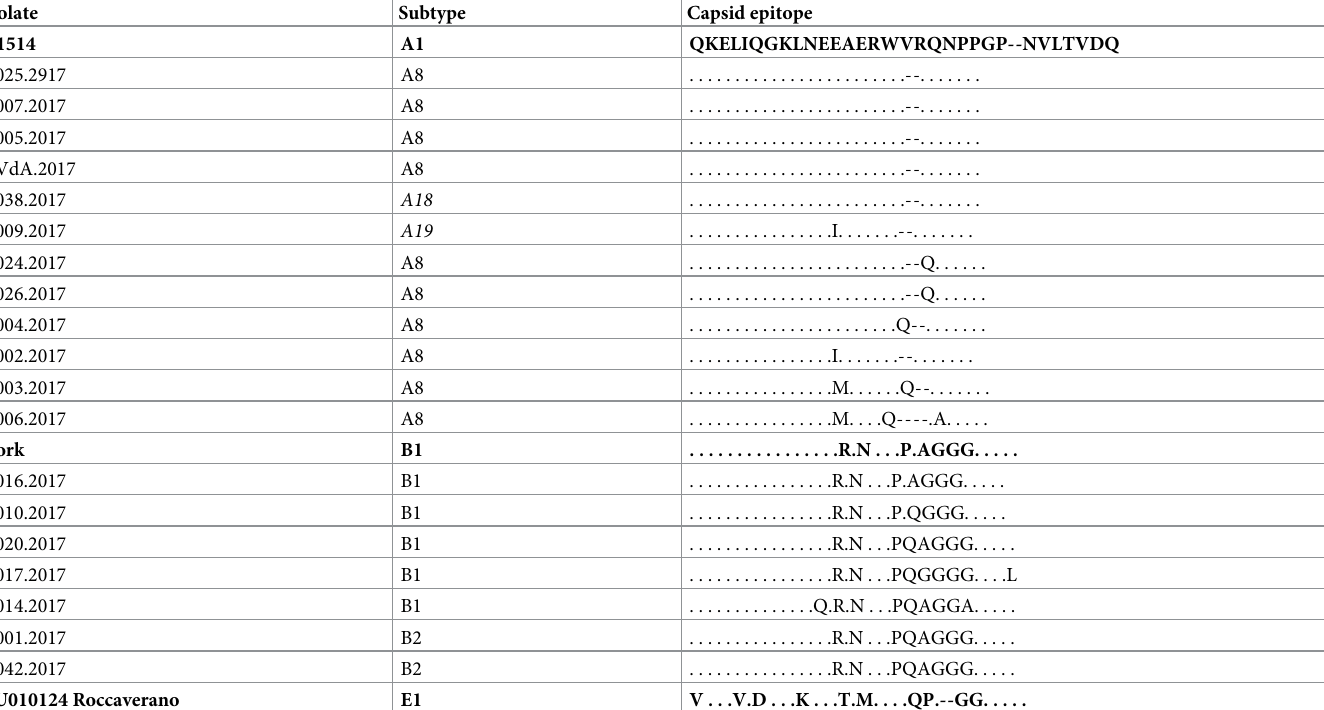
Table 2. Alignment of the immunodominant epitope within the gag gene. Reference genotype are reported in bold. Dots indicate identical residue comparing to the reference K1514 (MVVlike A genotype).